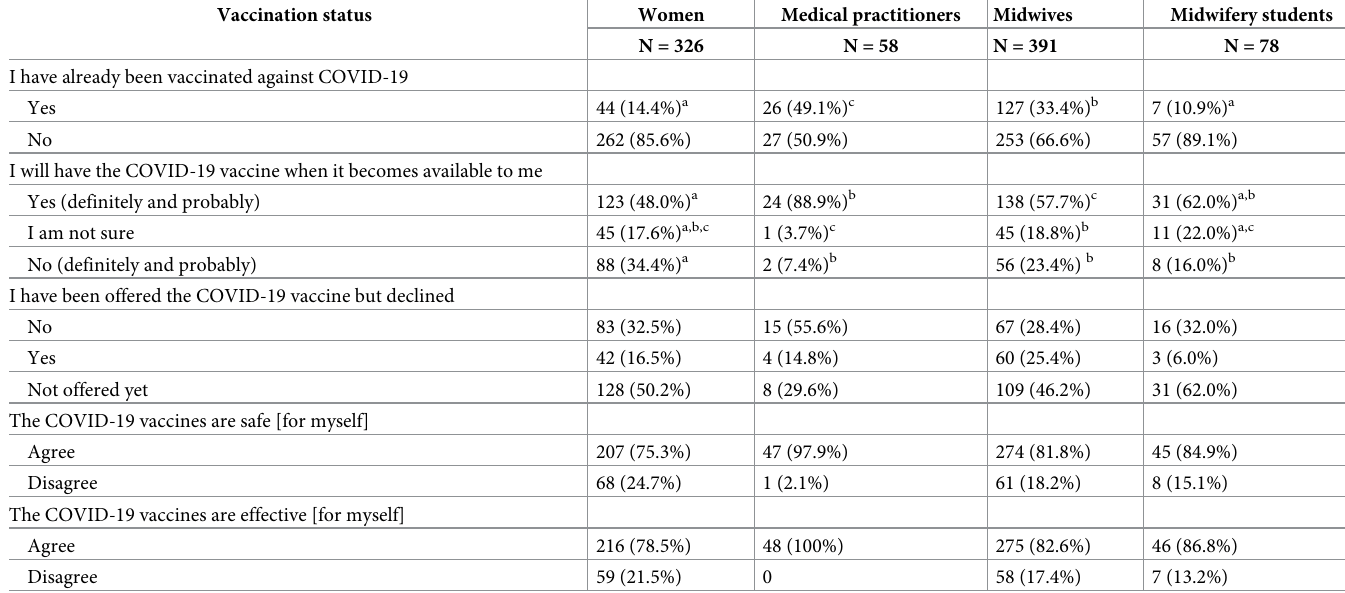
Table 3. Current vaccination status and intentions for COVID-19